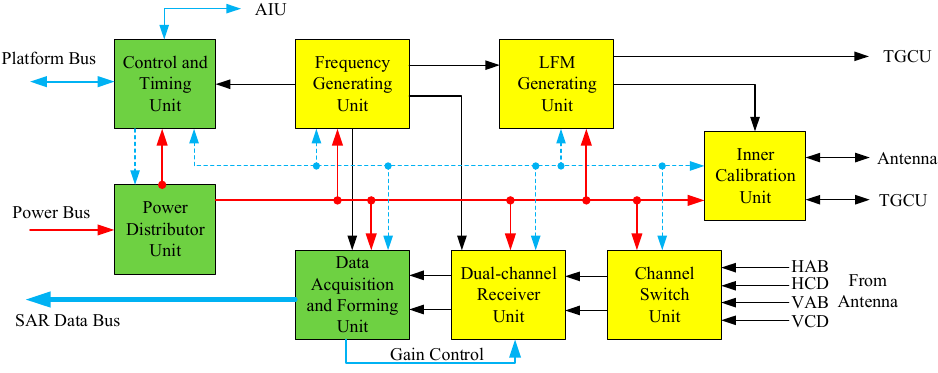
Figure 5. The electric block diagram of the SAR electrics subsystem.